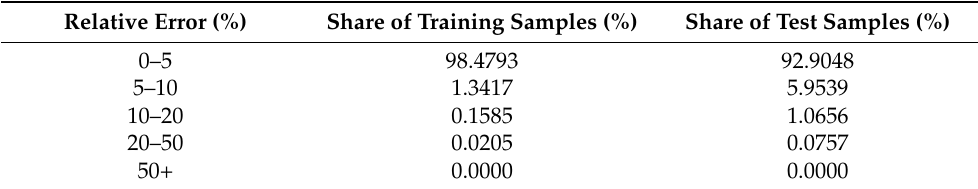
Figure 4. Distribution of occurrence for prediction errors for an ensemble model based on 4-layer models with 280 nodes per layer. Table 8. Function loss values for the training and test datasets for an ensemble model based on 4-layer models with 280 nodes per